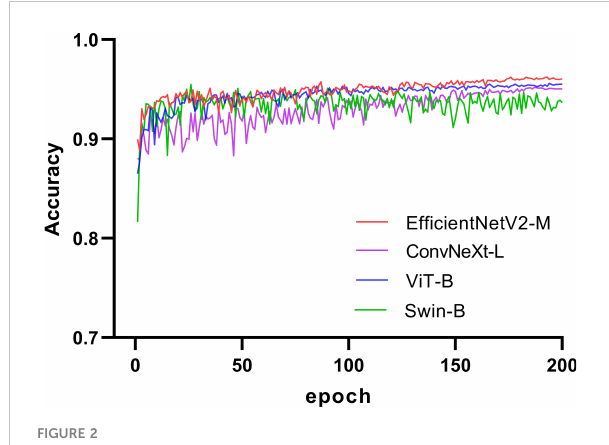
FIGURE 2 Training process of the four